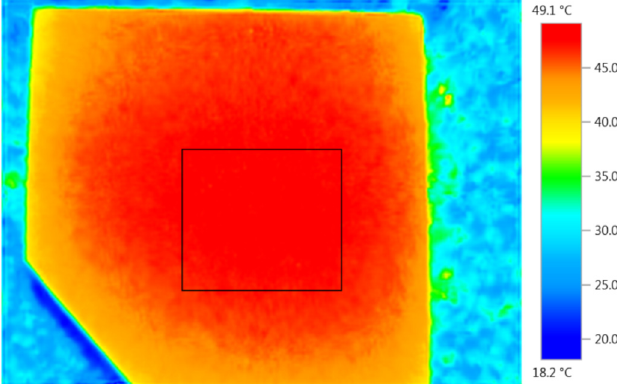
Fig. 1. Example of the thermal image of a grey paver with an averaging box.